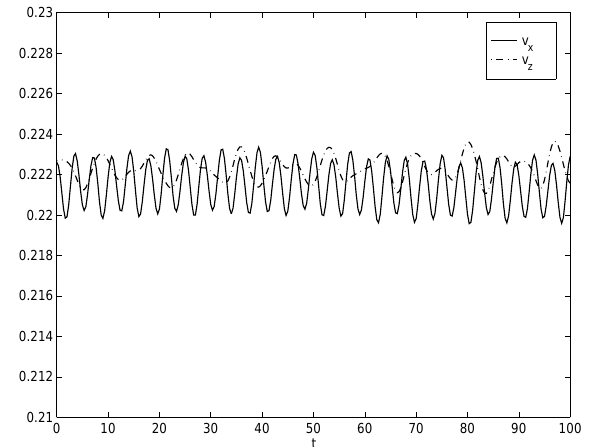
FIG. 20. rms velocities (in arbitrary units) for initially matched 6D stationary distribution ( (cid:99) (cid:121) (cid:97) (cid:173) (cid:51)(cid:44) m (cid:120) (cid:173) m (cid:121) (cid:173) m (cid:122) (cid:173) (cid:49)(cid:46)(cid:48)(cid:44) h (cid:120) (cid:173) (cid:48)(cid:46)(cid:53)(cid:51)(cid:44) h (cid:122) (cid:173) (cid:48)(cid:46)(cid:51)(cid:57) ).